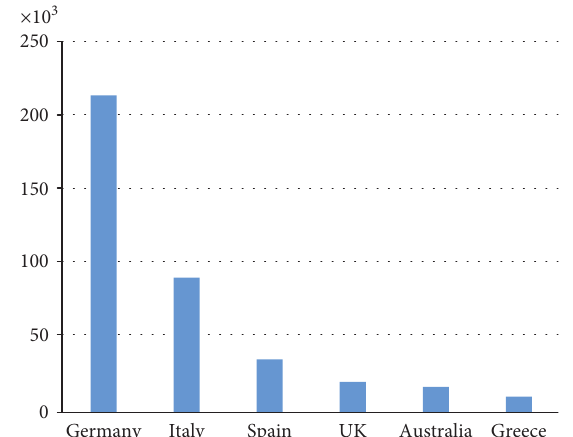
Figure 4: Solar PV installed power MW in 2006 – 2015, IRENA statistic 2016.